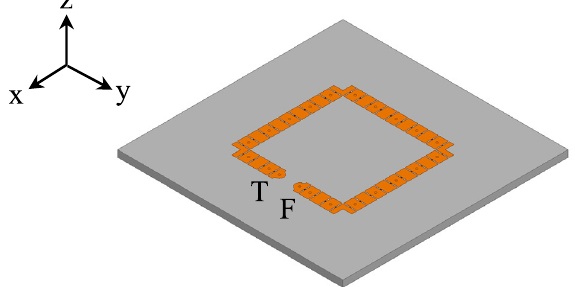
Fig. 19. Square metaloop-C antenna (SQR-MTLP-C), where N cell